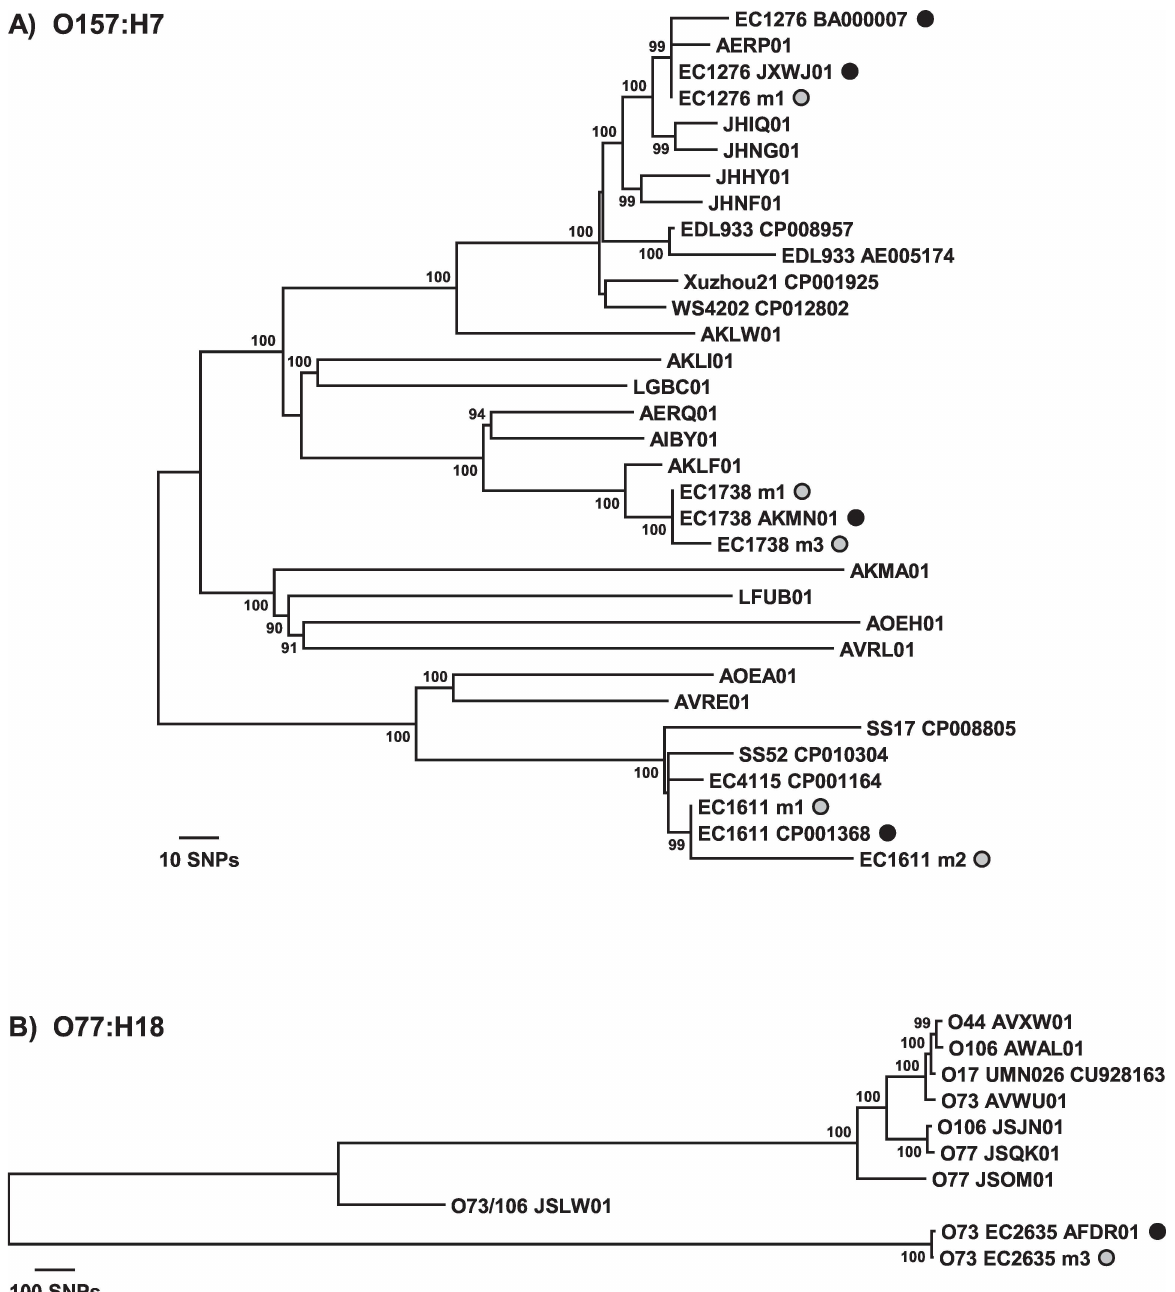
Fig 3. Finer-scale resolution of the phylogenetic relationships resulting from E . coli core gene SNP analysis. Neighbor-joining trees for the O157:H7 and O77:H18 clonalgroups were constructed using a p distancematrix and 500 bootstrapreplications. The spiked STEC strains and metagenomic samplesare indicatedby the black and gray circles, respectively.Bootstrap values > 80% are given at the